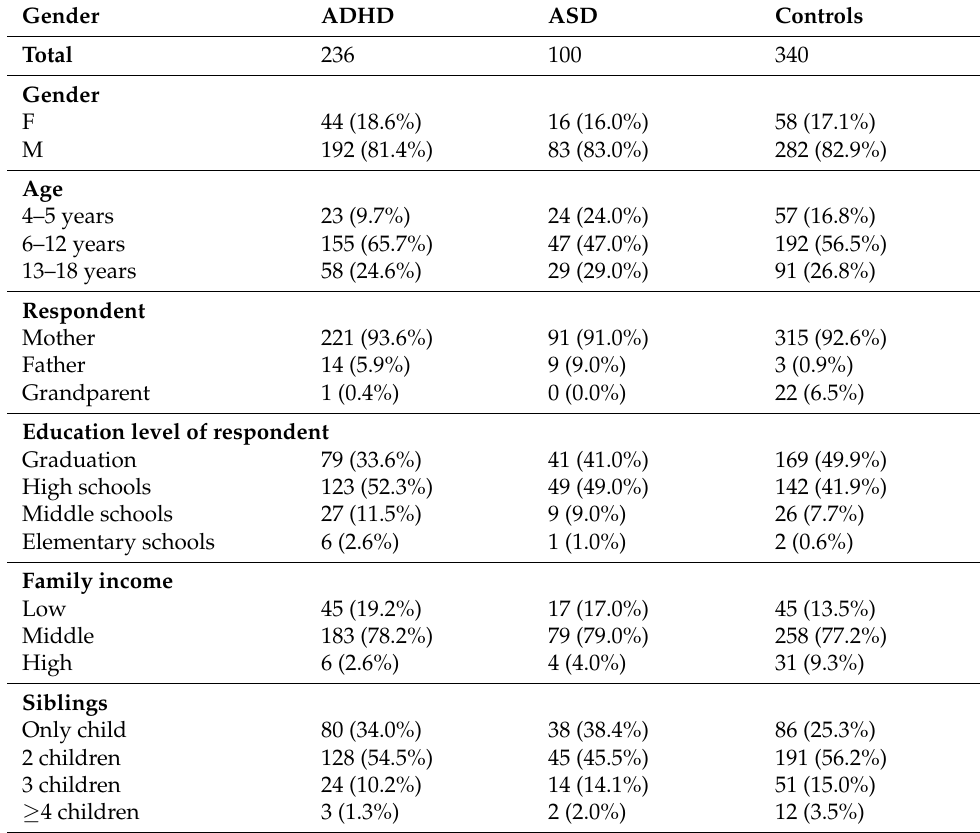
Table 1. Demographics of the three groups of children enrolled in this